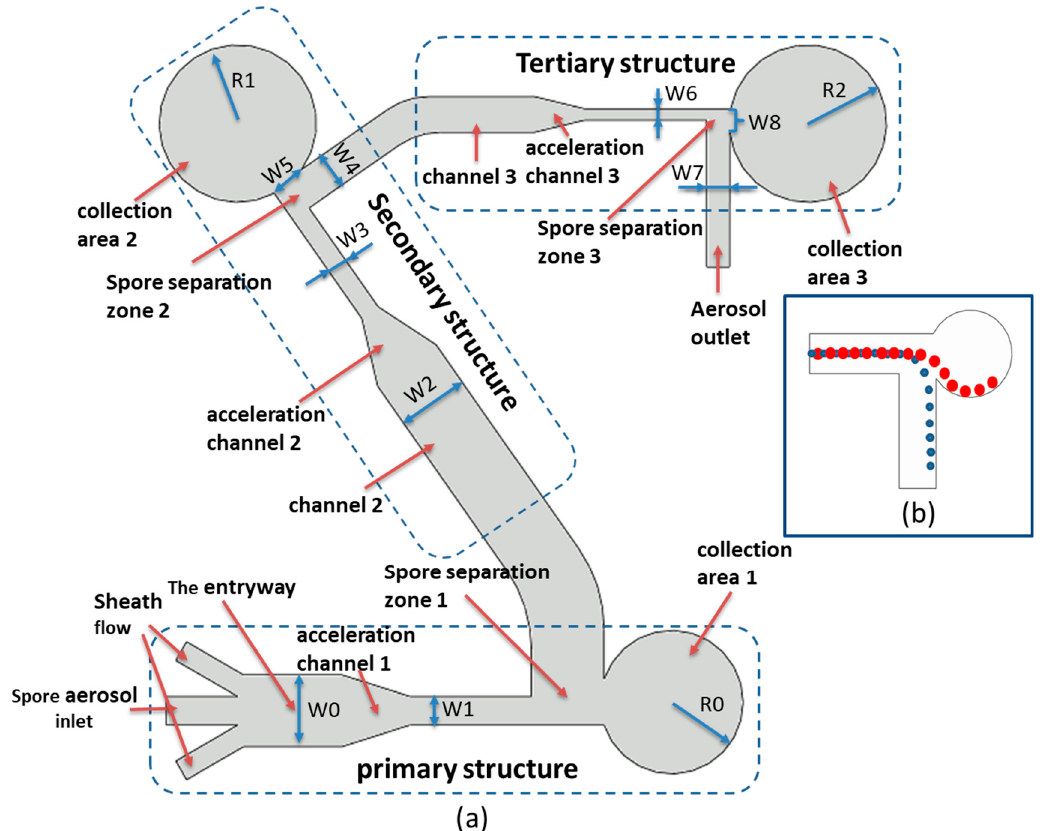
Figure 2. ( a ) Schematic diagram of the microfluidic chip structure. The chip consists of a tertiary structure. R0, R1, and R2 represent the radius of the first, second, and third enrichment regions, respectively, and W0–W7 represent the corresponding channel widths. ( b ) Sketch of the particle motion mechanism: small particles will follow the airflow into the next channel, and large particles will rush into the enrichment area. The red arrows point to the chip structure name, and the blue arrows indicate the chip size.